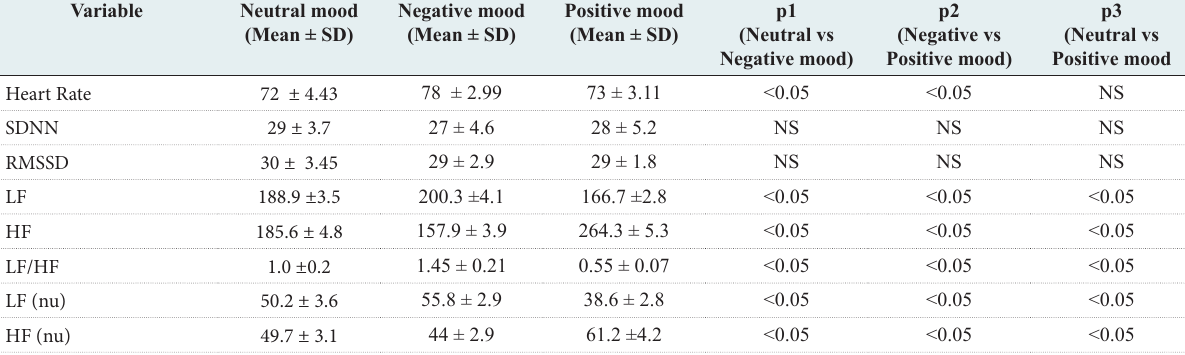
Table 3: Heart Rate Variability (HRV) parameters between different mood